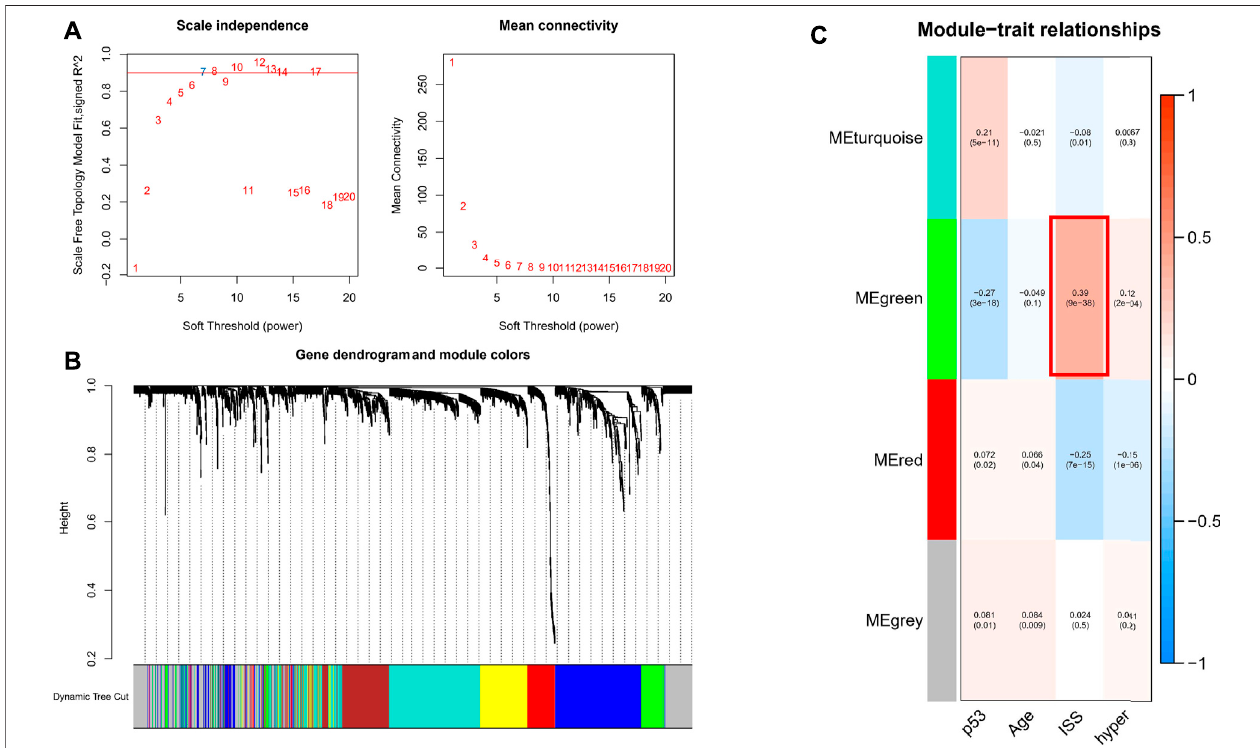
FIGURE 2 | WGCNA of all samples. (A) Soft threshold was identi fi ed by scale independence and mean connectivity. (B) Transcriptome data was classi fi ed into different modules. (C) Association between the modules and clinical traits.